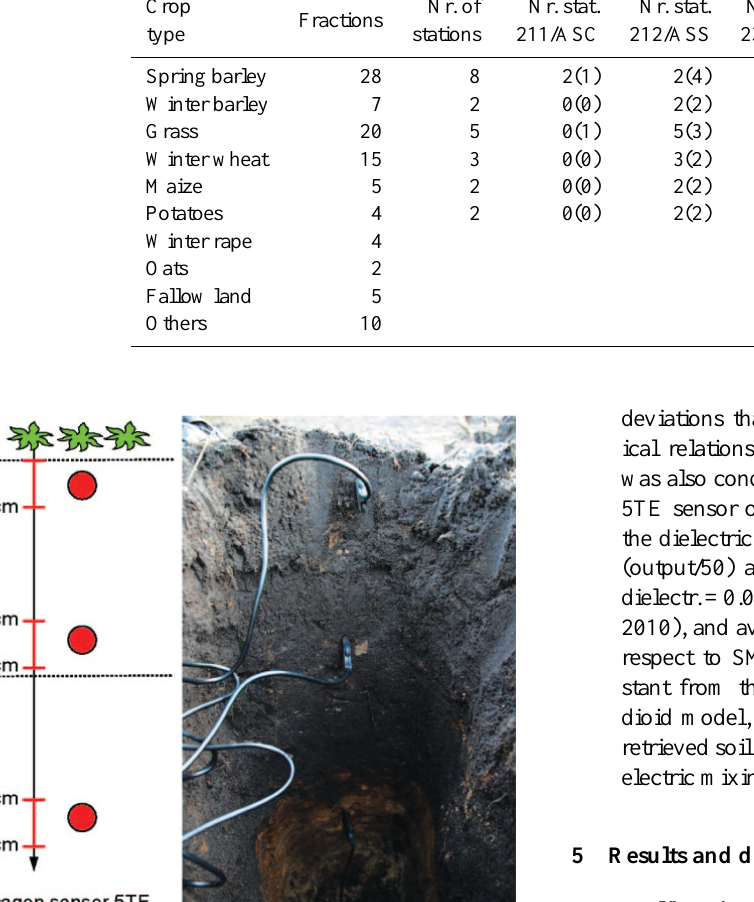
Table 5. Predominant crop types in the Skjern River Catchment, respective estimated fractions [%], number of allocated network stations per crop type and per composite class individually (theoretical and actual distribution). Crop Nr. of Nr. stat. Nr. stat. Nr. stat.